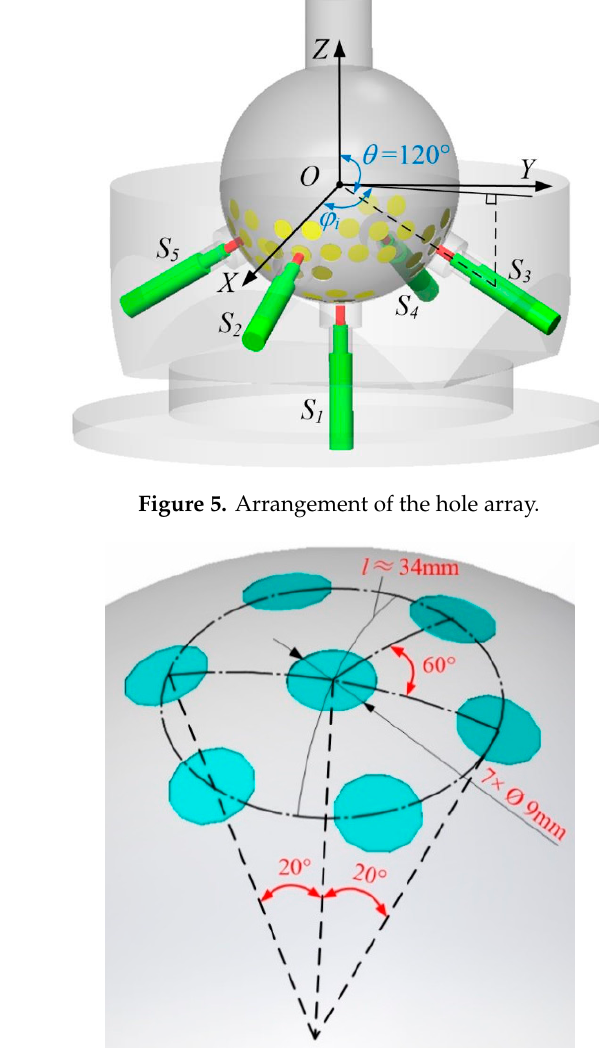
Figure 6. Arrangement of sensors and hole groups.